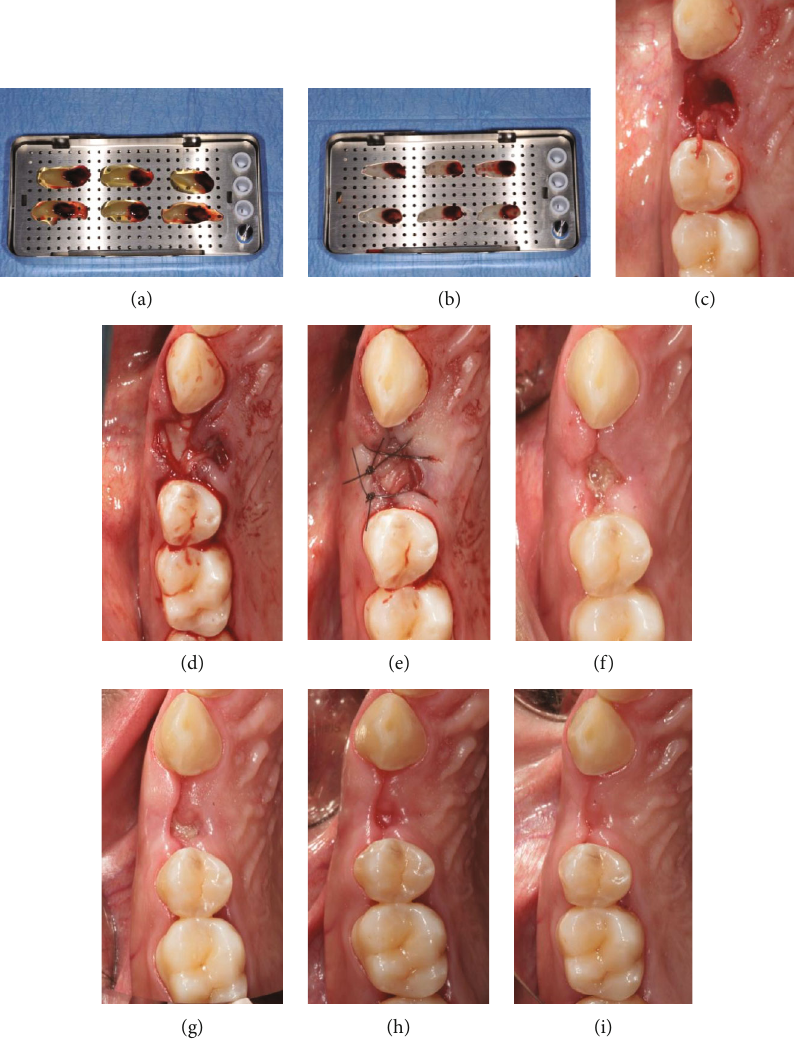
Figure 2: (a) L-PRF clots placed on a plate; (b) L-PRF membranes; (c) postextractive socket; (d) socket grafted with L-PRF membranes; (e) suture; (f) suture removal; (g) 14 days after tooth extraction; (h) 28 days after tooth extraction; (i) 60 days after tooth